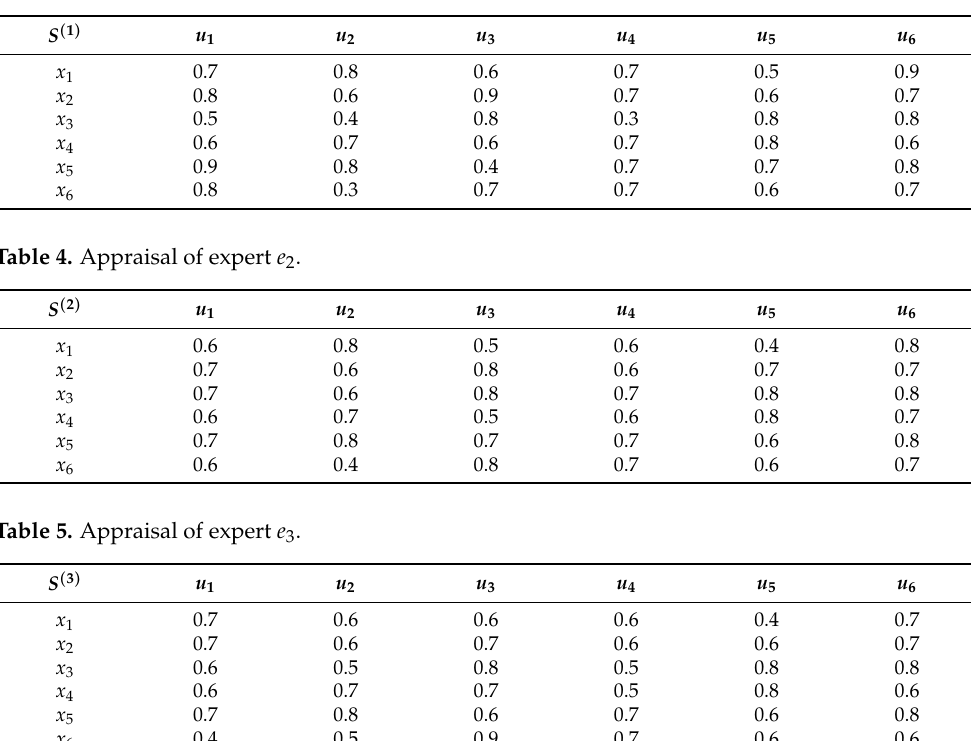
Table 3. Appraisal of expert e 1 .